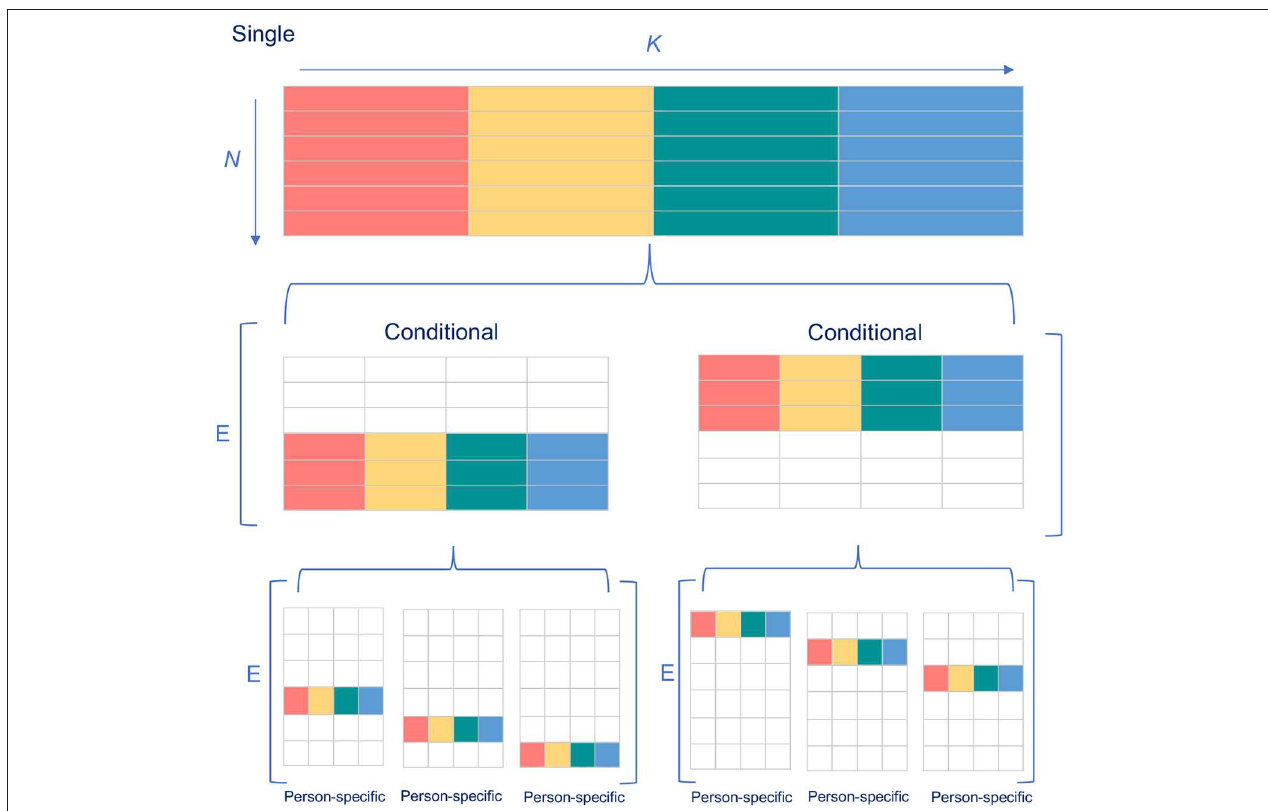
FIGURE 1 | Illustration of the relationship between the single, conditional and person-specific standard error of measurement. The rows symbolize examinees N and the columns parallel parts K . The different colors indicate different test scores for the K parallel parts. E[] refers to the expectation over the variances between the